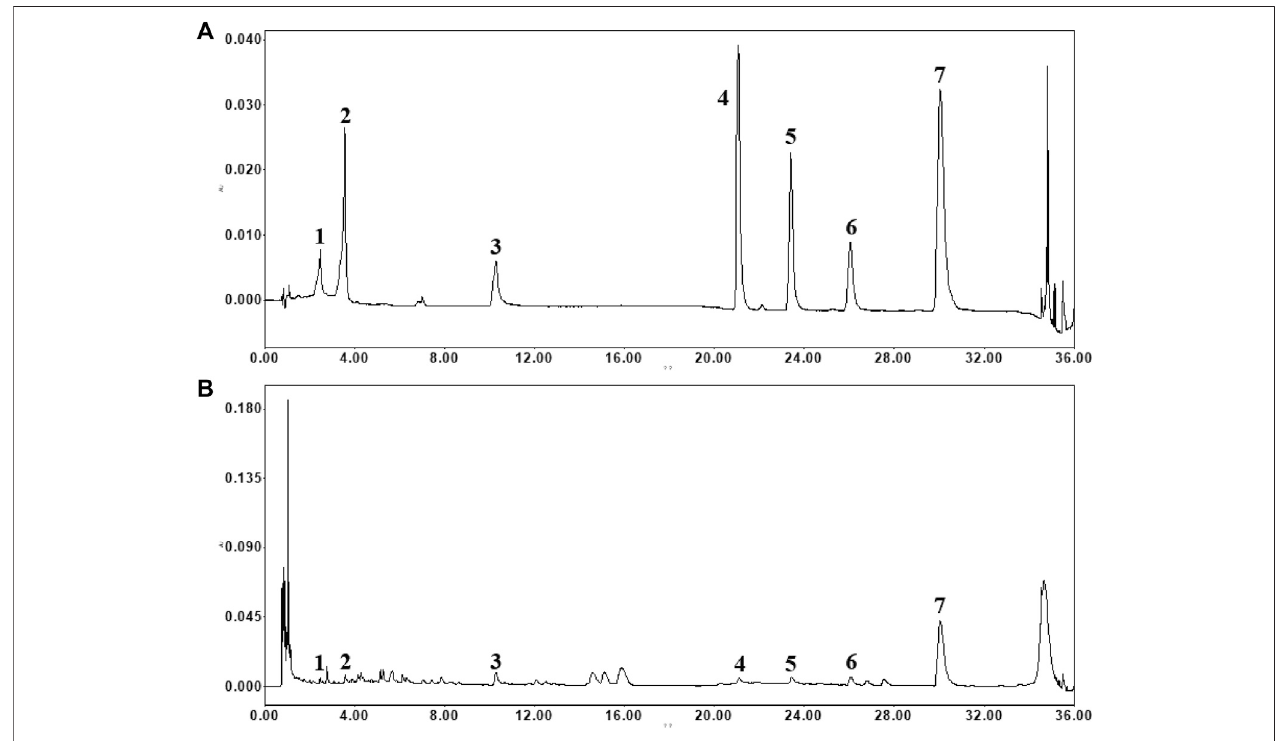
FIGURE 1 | The typical chromatograms of standard compounds (A) and sample (B) . (1) danshensu, (2) 5-caffeoylquinic acid, (3) paeoni fl orin, (4) astragalin, (5) rosmarinic acid, (6) lithospermic acid and (7) salvianolic acid B.